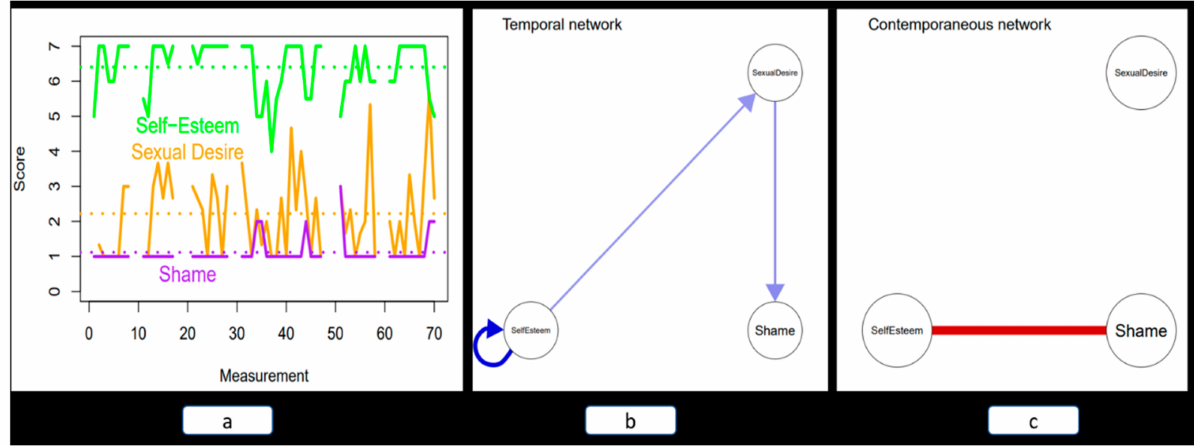
Figure 4. ESM output. ( a ) Representation of the timeseries of sexual desire, shame, and self-esteem of one ESM study participant. Data are collected over a period of 7 days, with a maximum of 10 measurements per day. ( b , c ) Nodes represent fluctuating feelings measured over time, and lines between nodes represent significant positive (=blue) or negative (=red) associations between these feelings. ( b ) The temporal network represents associations over time, with a time lag between measurements of 90 min on average. Note that self-esteem shows an autoregressive effect, which indicates that an increase in self-esteem 90 min previously predicts an increase in current self- esteem. ( c ) The contemporaneous network represents cross-sectional correlations. Note: Data are from participant 7 of the “CompulsivePornuseData.txt“ dataset accessed at https://osf.io/jha8n/ on 8 December 2022. Participant 7 scored high on a measure of compulsive porn consumption, considered himself addicted to porn, and watched porn seven times a